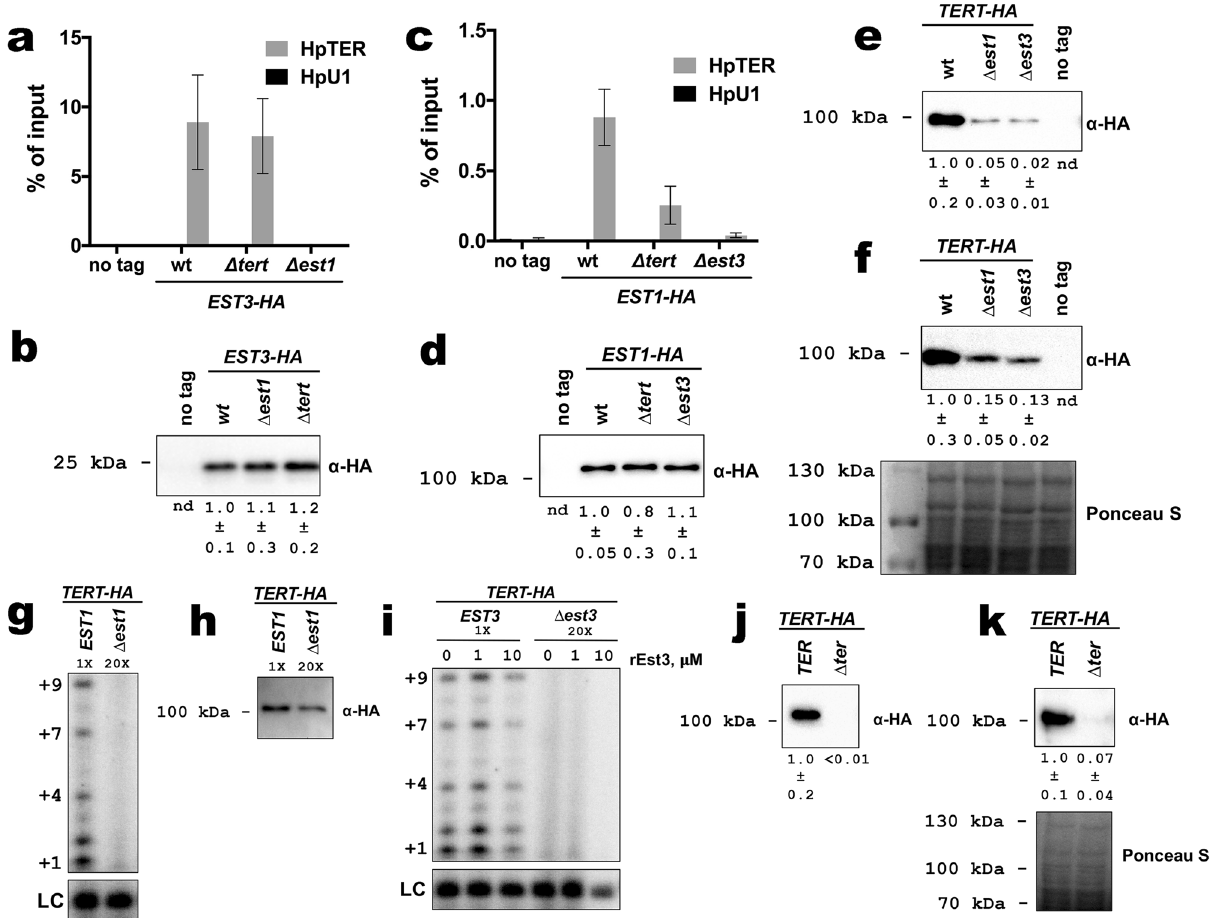
Figure 6. ( a ) Analysis of HpTER association with Est3-HA. Quantitative RT-PCR analysis of the HpTER co-precipitated on anti-HA agarose after incubation with extracts from the indicated strains. Small nuclear RNA HpU1 was also analyzed as a negative control. Data represented as percentage of input RNA (mean ± SD). ( b ) Western blot analysis (with anti-HA antibodies) of Est3-HA protein levels in anti-HA precipitates prepared from the equal amounts of cultures of the indicated strains. Numbers below are quantifications of band intensities (mean ± SD) calculated using values from three biological replicates. “nd”—not determined. Extracts prepared from three independently grown cultures of each strain were utilized for the experiments in ( a ) and ( b ). ( c ) and ( d ) same as ( a ) and ( b ), respectively, only with Est1-HA protein. ( e ) same as ( b ) but with TERT-HA protein. 1/2 portions of the IP sample obtained from 400 ml YPD cultures (OD 600 ~ 1) were used for analysis. ( f ) Anti-HA Western blot analysis of TERT-HA protein levels in extracts prepared from the indicated strains (upper panel). Ponceau S-stained membrane served as a loading control (lower panel). Equal amounts of input samples were used for analysis. Numbers below the blot are quantifications of band intensities (mean ± SD) calculated using values from three biological replicates. “nd”—not determined. ( g ) Telomerase activity assay of TERT-HA EST1 and TERT-HA ∆est1 IP samples with HD5 primer. “LC” loading control. 1/10 portion of the IP sample obtained from 400 ml YPD culture (OD 600 ~ 1) of TERT-HA EST1 and in 1/2 portion of the IP sample obtained from 1,600 ml YPD culture (OD 600 ~ 1) of TERT-HA ∆est1 were used for the experiment. ( h ) Western blot analysis of samples from ( g ). ( i ) same ( g ) but with TERT-HA EST3 and TERT-HA ∆est3 IP samples. Telomerase on beads was pre-incubated with recombinant Est3 (rEst3) (1 or 10 μM) where indicated. ( j ) same as ( e ) but with TERT-HA ∆ter strain. ( k ) same as ( f ) but with TERT-HA ∆ter strain. Original (full lane view, no contrast adjustment) blots and gels from ( b , d – k ) are shown in Supplementary Fig. ability of OB-fold proteins; among other known functionalities are their interactions with RNA and proteins, including other OB fold units. OB fold domains were found in a number of telomere-binding proteins from various species, where they demonstrate all these modes of interaction. The structural core of OB-fold proteins is composed of conserved beta-strand elements β1–β5 forming the two anti-parallel beta-sheets, connecting loop elements L12, L23, and L45 of variable length, and optional α-helices, the most conserved of which is a C-terminal helix (C-helix). Analysis of the architecture of telomeric OB fold-containing proteins 53 suggests that the length and position of connecting elements and alpha-helices may reflect the interaction preferences of a particular OB fold module. Figure 8 shows the examples of the ssDNA- and protein-binding telomeric proteins 54–56 with the focus on their interaction interfaces and the position of the connecting element L45. Typical for these proteins is